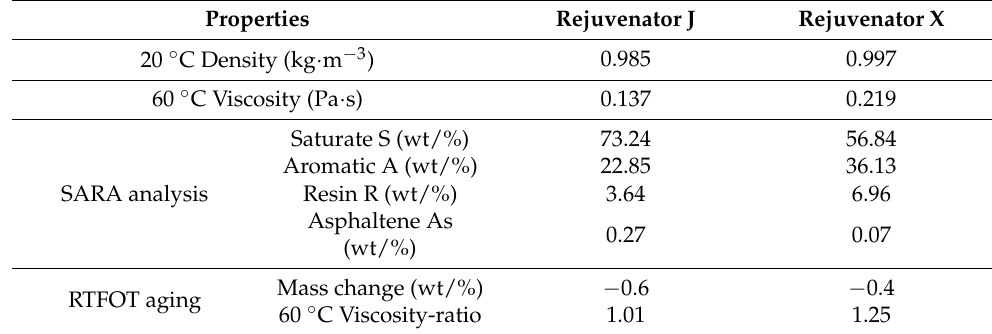
Table 2. Conventional properties of pure rejuvenators.